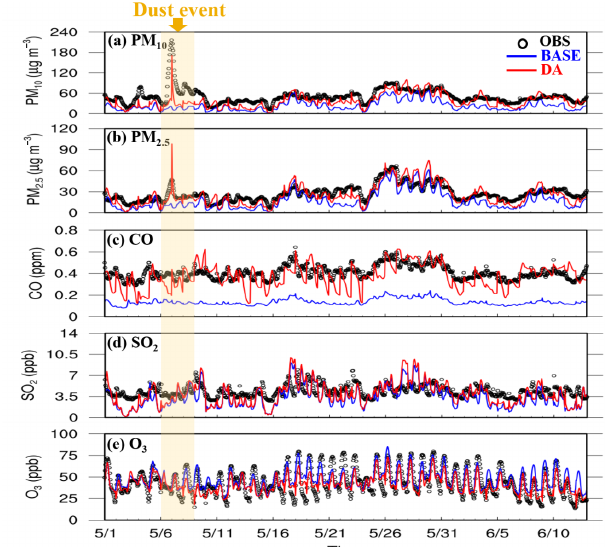
Figure 5. Time-series plots of hourly (a) PM 10 , (b) PM 2 . 5 , (c) CO, (d) SO 2 and (e) O 3 concentrations at 264 Air Korea stations. Open black circles (OBS) represent the observed concentrations. Blue and red lines show the results simulated from the BASE RUN and DA RUN over South Korea,